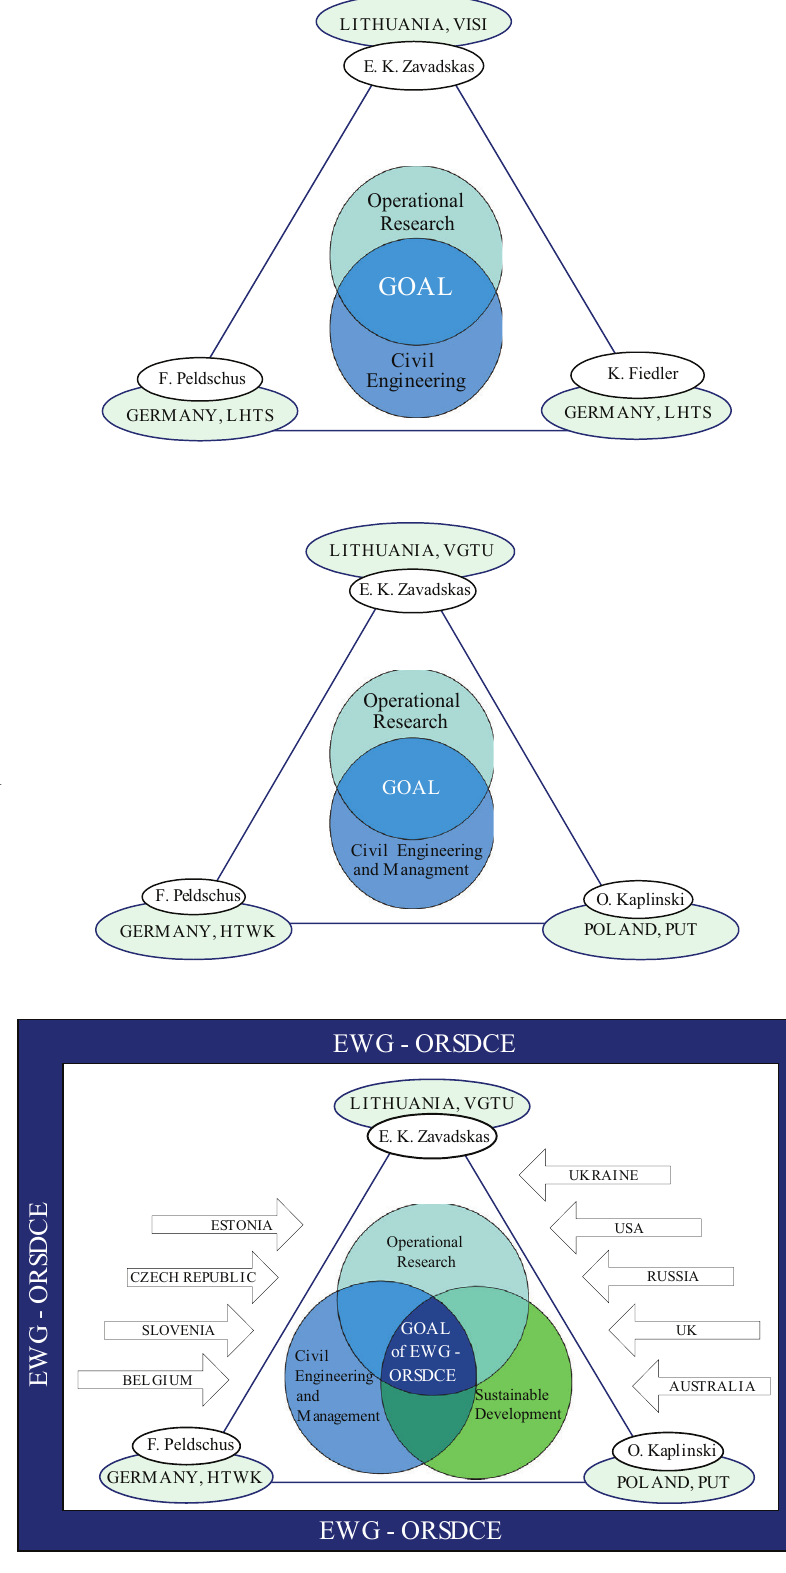
Fig. 1. Development of collaboration between three German–Lithuanian–Polish academic centres during